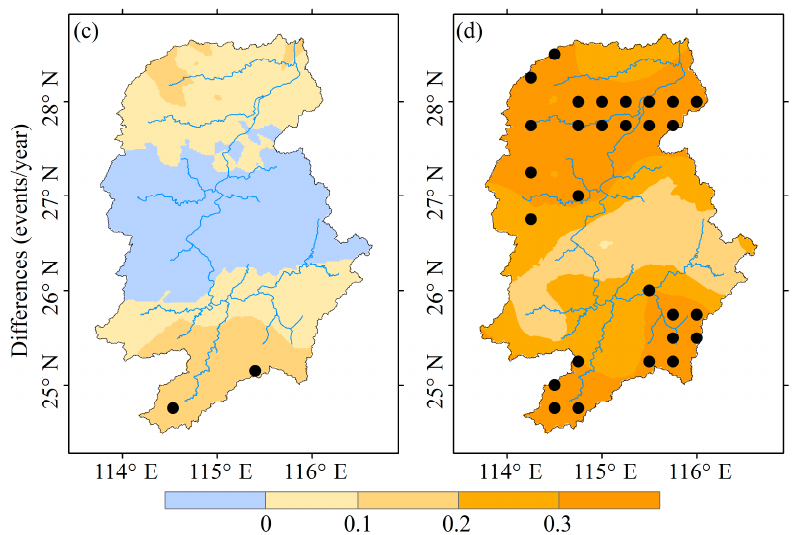
Figure 6. Spatial patterns of CDHW frequency in ( a ) the observations and ( b ) ERA5 from 1961 to 2018, and annual mean differences of CDHW frequency in ( c ) the observation and ( d ) ERA5 between 1997–2018 and 1961–1997, respectively. The solid black dots indicate passing the 0.05 significance level based on a two-sample t-test for equal means.